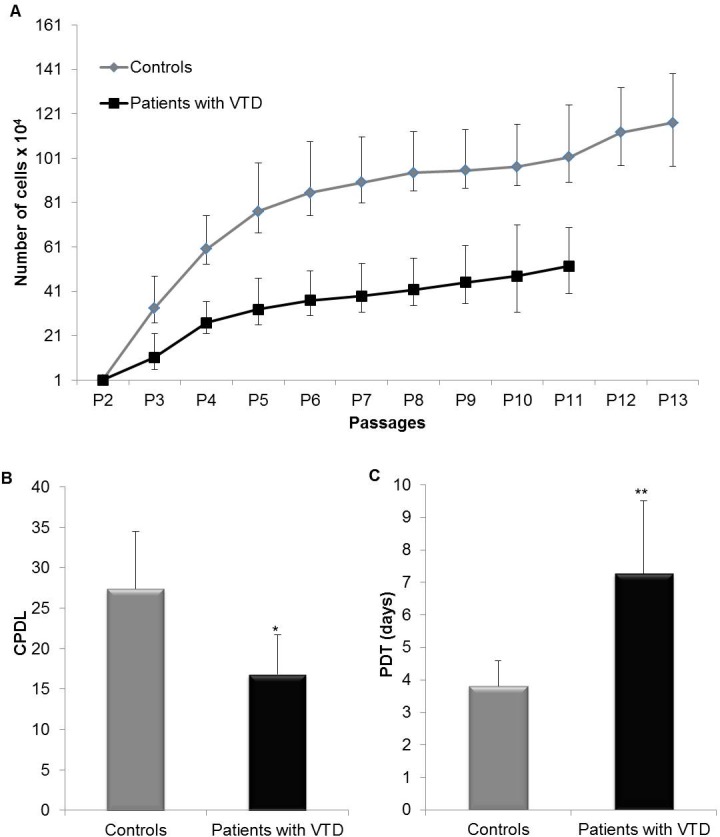
Proliferative potential of ECFC-ECs from peripheral blood of controls and patients with VTD.This figure shows the results from ECFC-ECs obtained from VTD patients and controls regarding the following: (A) Proliferation of ECFC-ECs. Each point on the graph indicates the accumulated cell number along different reseedings. (B) Cumulative population doubling (CPD) levels. (C) Population doubling times (PDT). Results are expressed as mean ± standard deviation of five independent experiments. *P = 0.032 for CPDs and **P = 0.017 for PDTs.